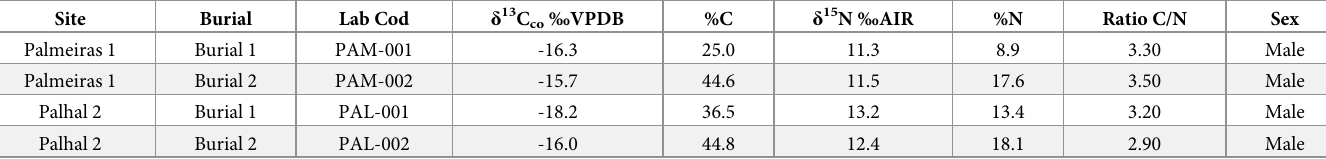
Table 2. Human stable isotopes results from